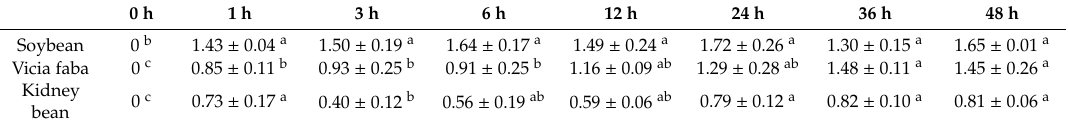
Table 5. Total phenolic contents for di ff erent times of colonic fermentation (mg GAE / g DW) A